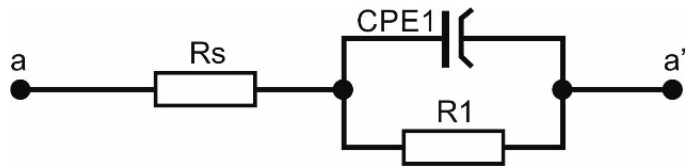
Table 1. Values obtained during potentiodynamic investigations.